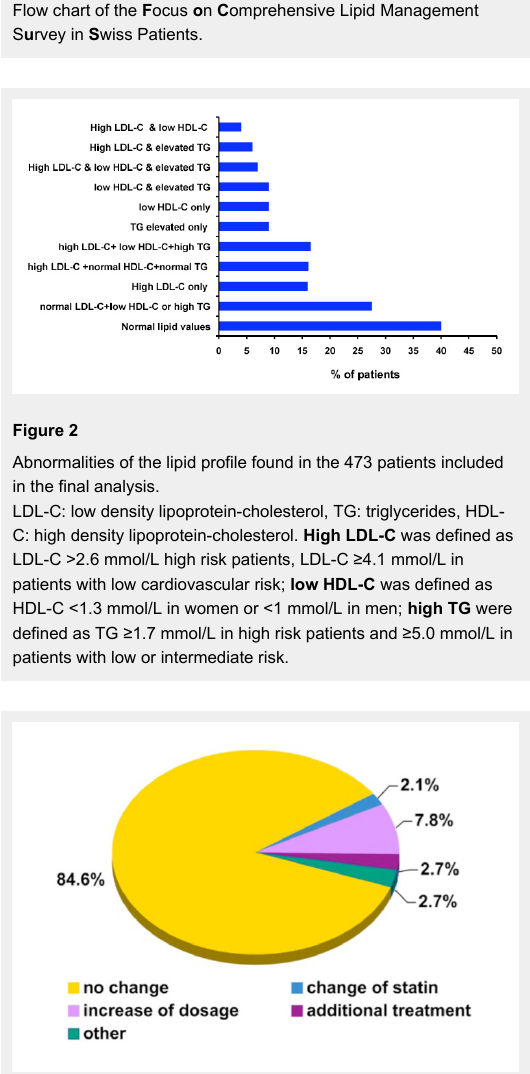
Flow chart of the F ocus o n C omprehensive Lipid Management S u rvey in S wiss Patients.